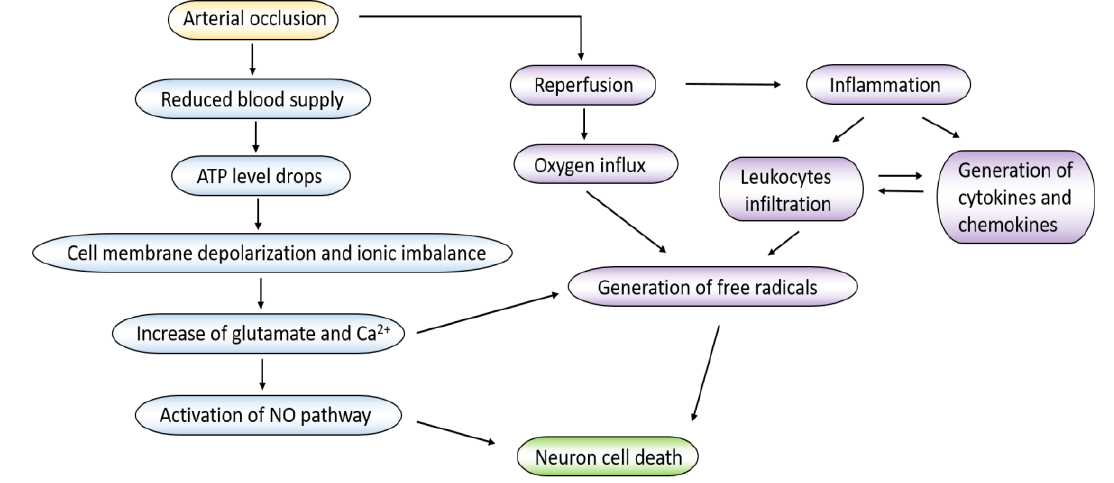
Figure 1. The cellular process and mechanism of ischemic stroke and the ischemic injury cascade.